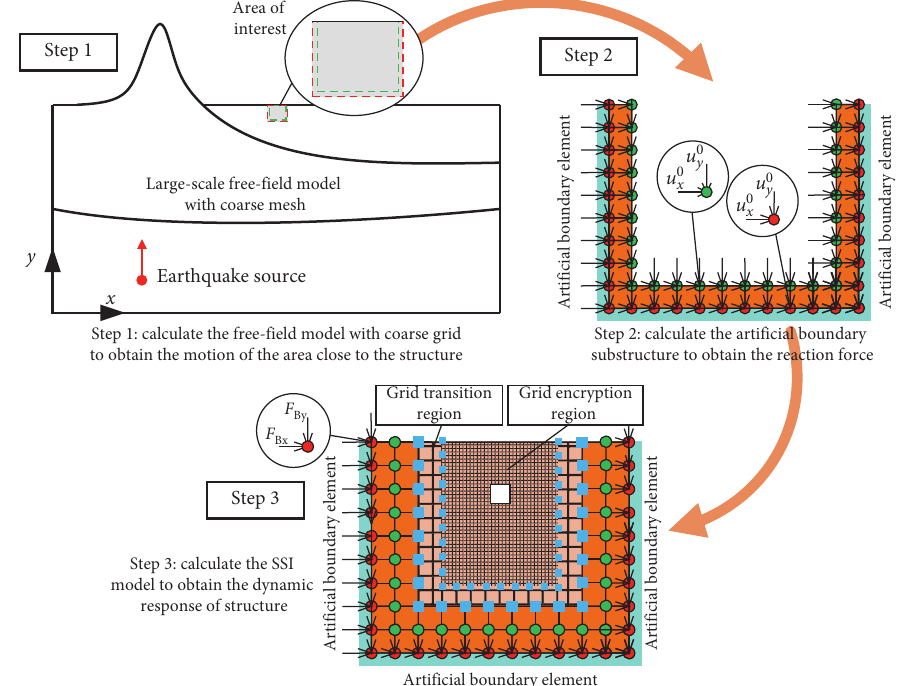
Figure 3: Three-step flowchart of the multiscale method.